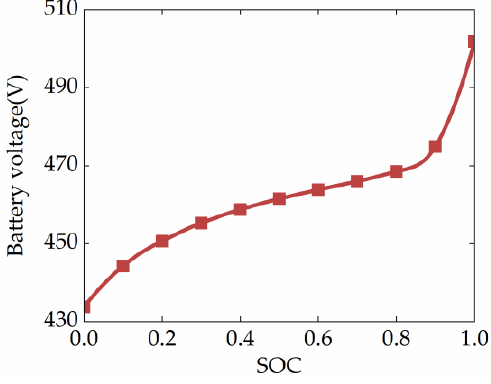
Figure 3. Characteristic curves of the battery.